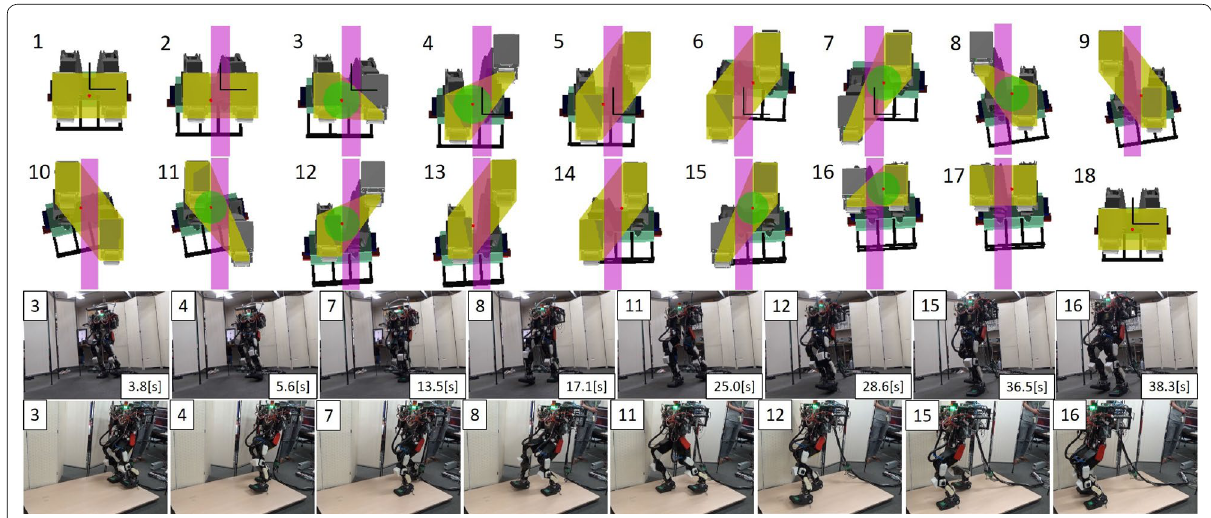
Fig. 13 Locomotion based on stability margin maximization with lateral constraint ε =